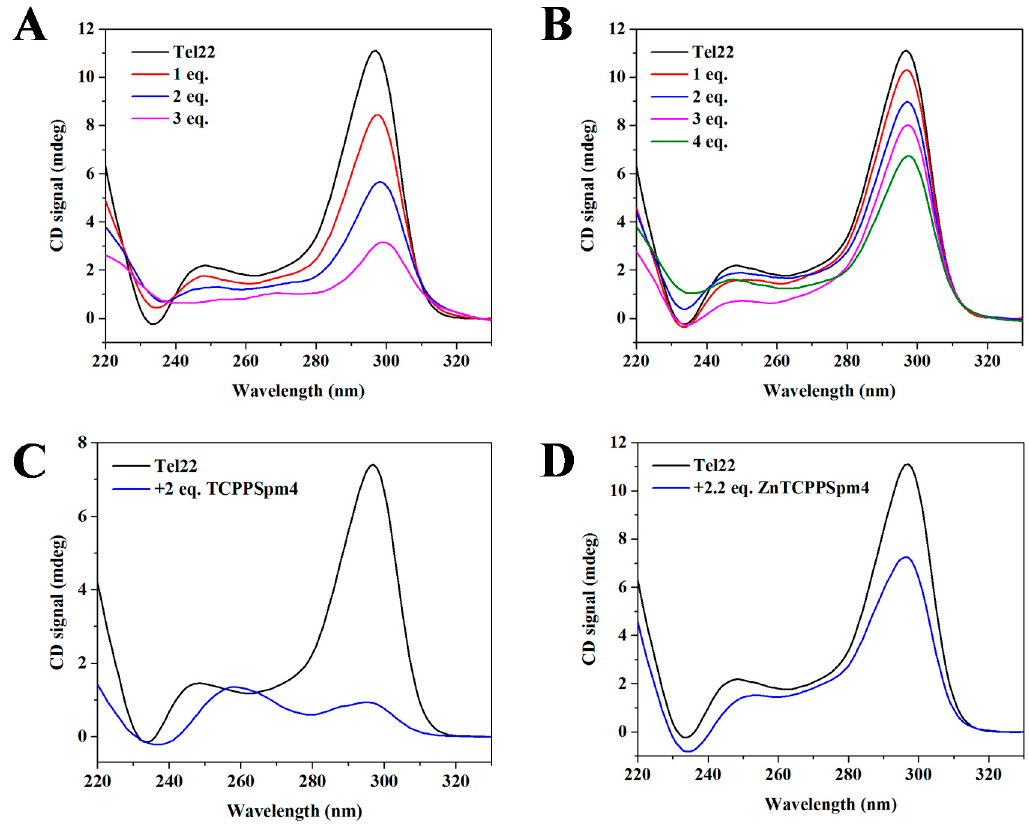
Figure 7. CD titration of 15.0 µ M Tel22 with up to 4 eq. of ( A ) TCPPSpm4 and ( B ) ZnTCPPSpm4. Samples were incubated for 12 min after each addition of the porphyrin. CD annealing of ( C ) 10.0 µ M Tel22 with 2.0 eq. of TCPPSpm4 and of ( D ) 15 µ M Tel22 with 2.2 eq. of Zn TCPPSpm4. Data were collected at 20 ◦ C. We have also completed CD melting on the annealed samples and saw no-to-weak stabilization (Figure S4).